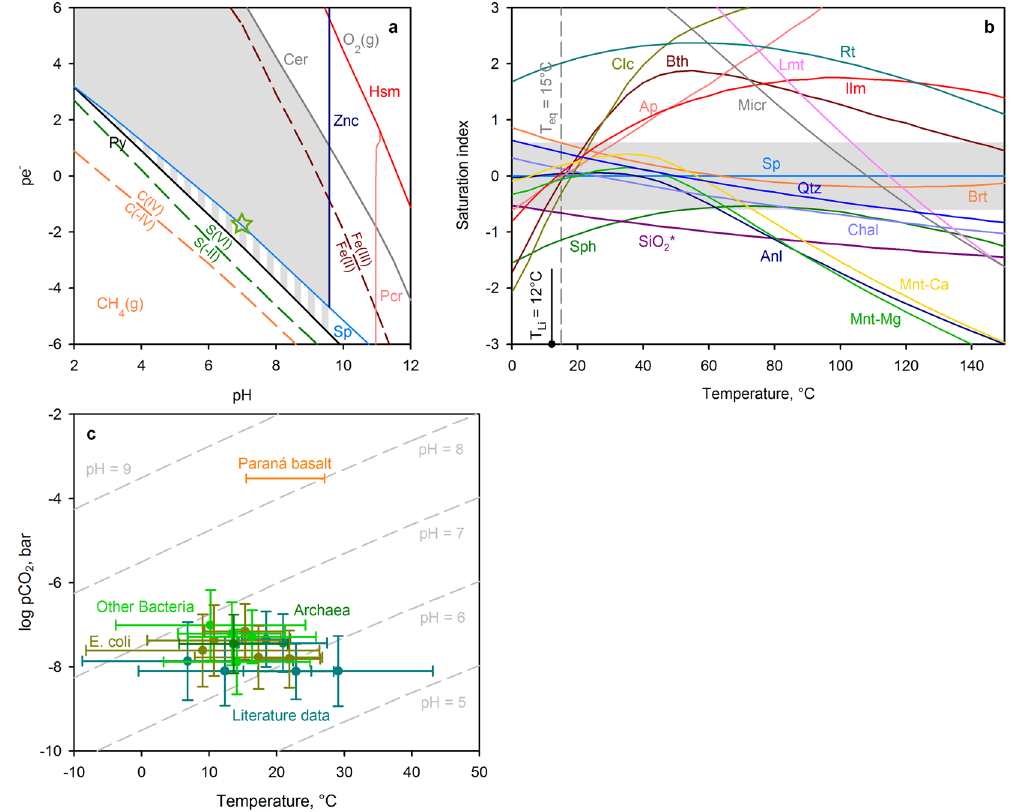
Figure 4. Constraints on the Hadean environment. ( a ) A pe − -pH diagram illustrating the redox buffers and stability fields of minerals calculated for E. coli composition at 15 °C and 1 bar. The shaded region outlines the conditions where the measured solution is stable. ( b ) Determination of equilibrium temperature (T eq ) for E. coli composition at pH-pe − conditions marked by green star on the Fig. 4a. The grey area represents 2 σ uncertainty for equilibrium. ( c ) The upper limit for pCO 2 in the cradle environment constrained by the precipitation of sphene. Calculations are based on temperatures and pH estimated using the mineral equilibria approach. CO 2 pressure calculated using compositions of archaea - dark green, E. coli – dark yellow, other bacteria - light green, and literature data (Supplementary Table 1) - dark cyan. Uncertainties are 1 σ . Mineral abbreviations: Anl – analcime, Ap – Cl-apatite, Brt – barite, Bth – berthierine, Cer – cerianite, Chal – chalcedony, Clc – clinochlore, Fe-smc – Fe smectite, Hsm – hausmannite, Ilm – ilmenite, Lmt – laumontite, Micr – microcline, Mnt-Ca